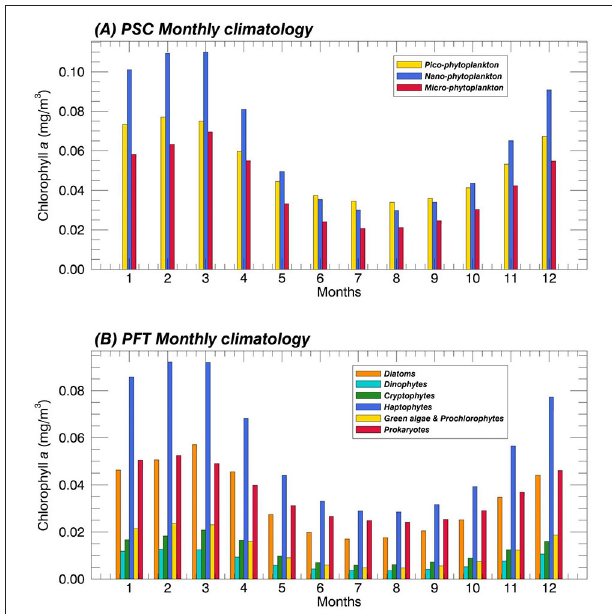
FIGURE 7 | Mean monthly climatology (1998–2015) of the PSCs (A) and the PFTs (B) over the Mediterranean Sea in terms of their contribution to the TChl a (mg m − 3 ). The PSCs and PFTs are retrieved applying the new regional algorithms (see Table 4 ) on the daily Total Chlorophyll a time series (Mediterranean reprocessed product produced by the